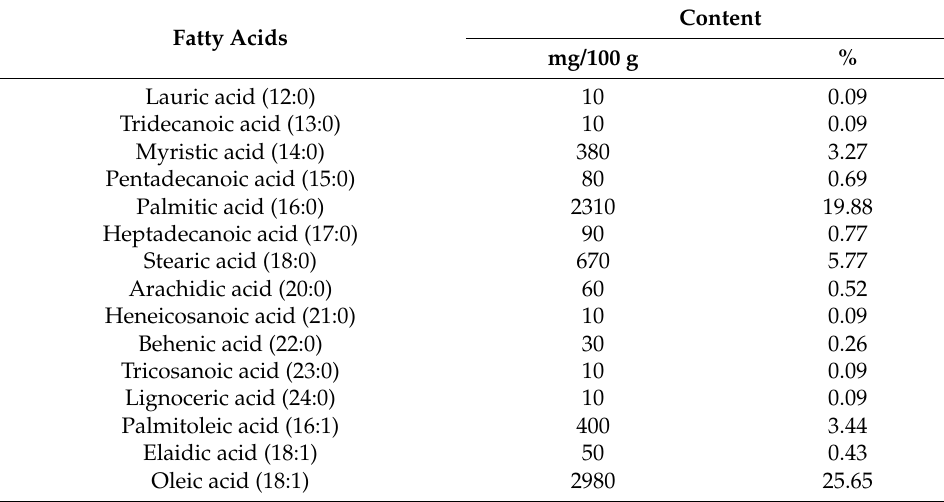
Table 9. Fatty acid profile of braised mackerel with